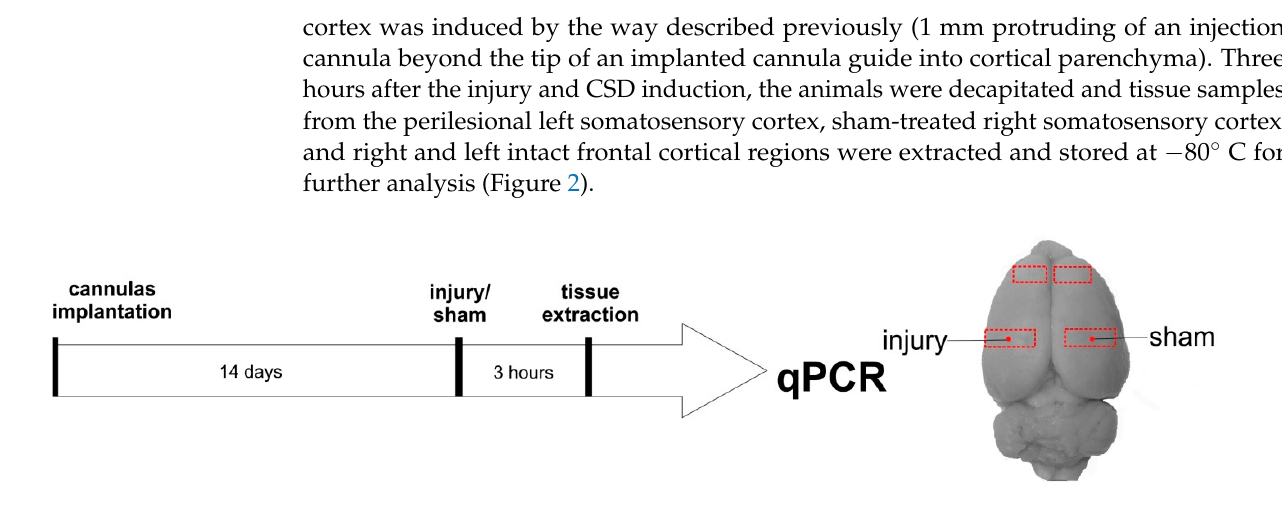
Figure 2. Experimental design and cortical regions harvested for qPCR analysis.